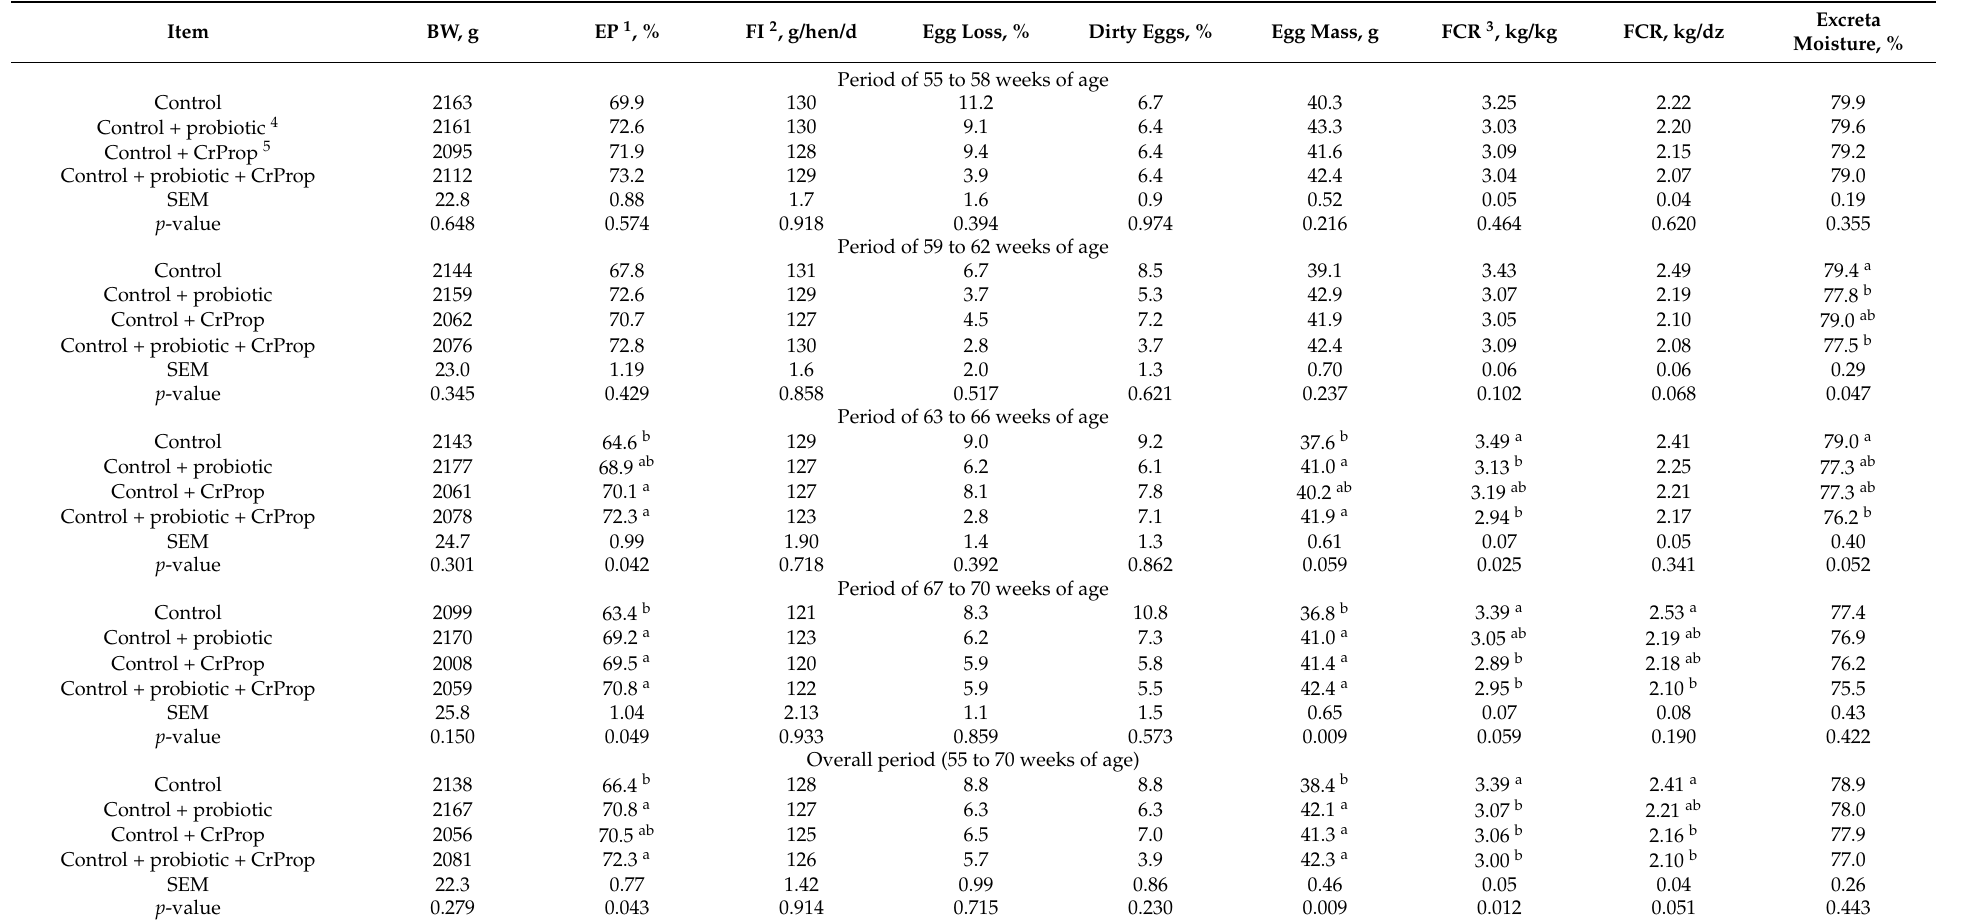
Table 2. Productive performance and excreta moisture of layer breeders fed diets supplemented with the probiotic and chromium propionate from 55 to 70 weeks of